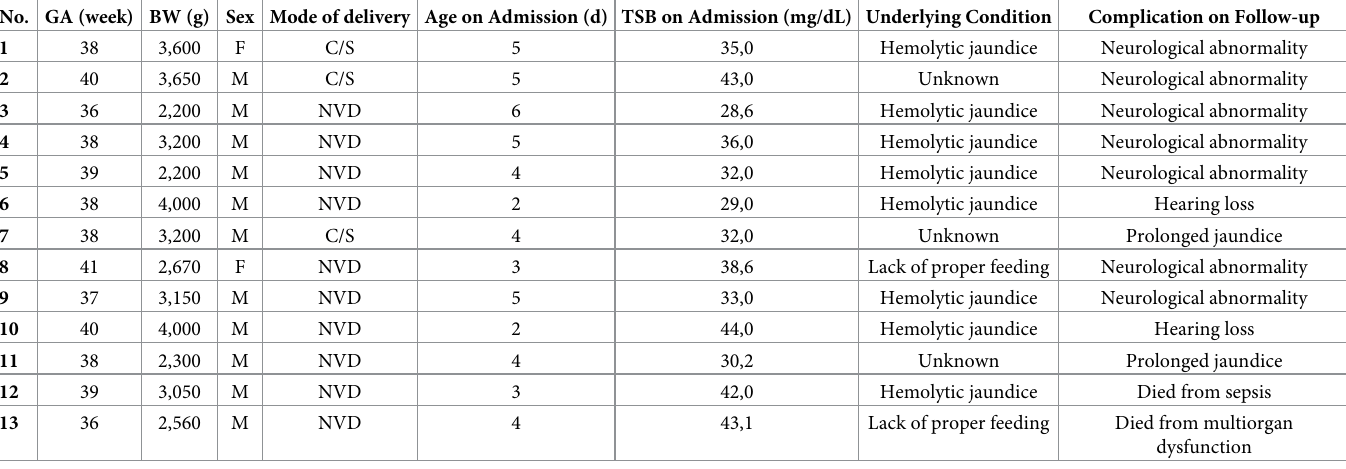
Table 3. Characteristics of patients with acute bilirubin